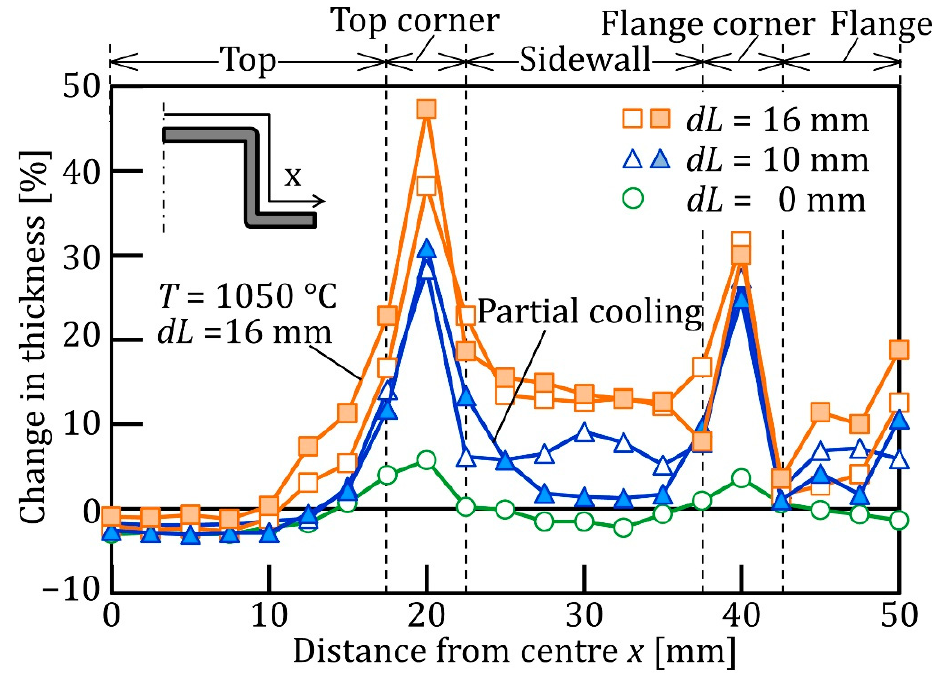
Figure 7. Distributions of change in thickness in hot hat-shaped bent parts. The forming force in hot hat-shaped bending using compression in-plane direction is shown in Figure 8. Although the forming force for d L = 0 mm without